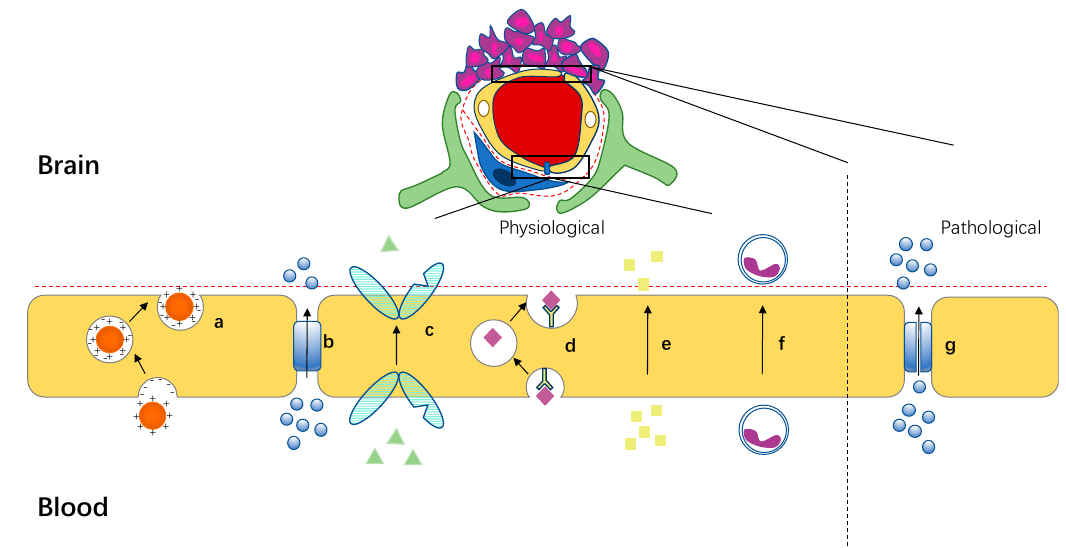
Figure 2. Schematic of various mechanisms across the BBB. ( a ) Adsorption-mediated endocytosis. ( b ) Water-soluble small molecules pass through the paracellular pathway. ( c ) Transporter-mediated endocytosis. ( d ) Receptor-mediated endocytosis. ( e ) Lipid-soluble small molecules pass through the transcellular pathway. ( f ) Cell-mediated endocytosis. ( g ) The tight junction of the BBB at the tumor is destroyed, which can increase the number of small molecules passing through the BBB.